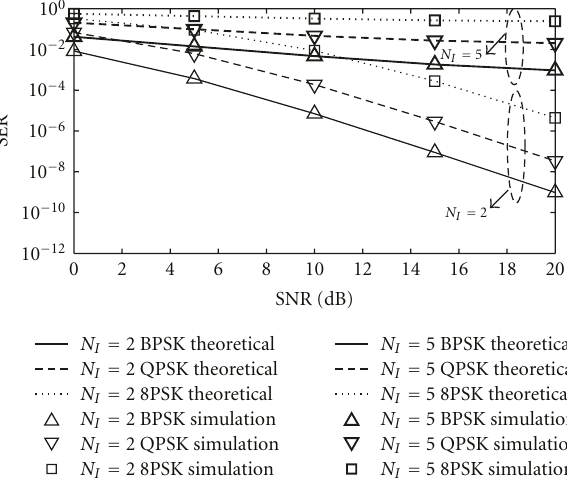
Figure 4: SER versus L with di ff erent values of N I when K = 6 and SIR = 0dB, and SNR = 10dB.